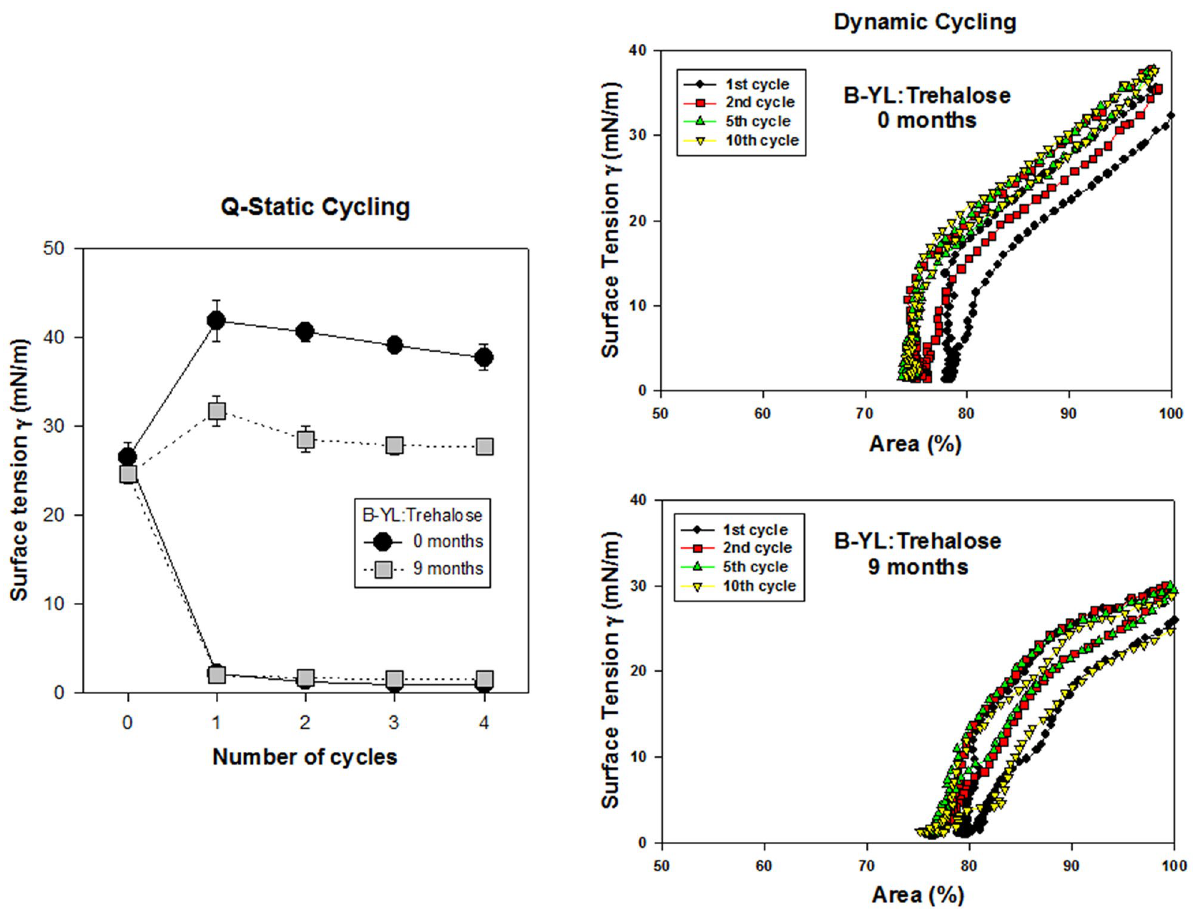
Figure 6. Quasi-static (left) and dynamic cycling (right) isotherms at captive bubble surfactometry of a B-YL: Trehalose surfactant (DPPC:POPG:B-YL:Trehalose:NaCl 49:21:3:25:2) at baseline and after 9 months of exposure to 40 °C and 75% relative humidity. Differences in minimum surface tension at quasi-static cycling and % compression area to reach minimum surface tension at dynamic cycling were not statistically